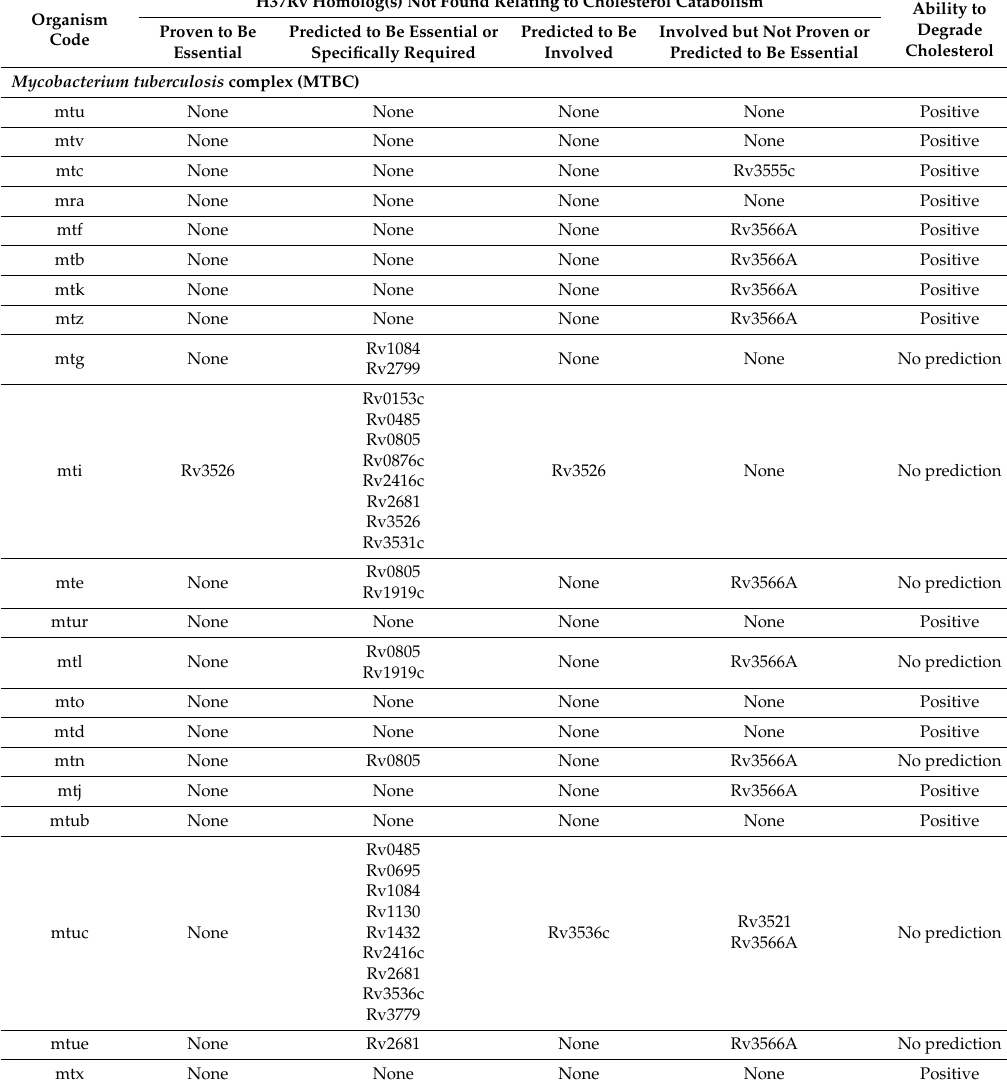
Table 2. Comparative analysis of cholesterol degrading genes/proteins in mycobacterial species. M. tuberculosis H37Rv homologs belonging to different categories not found in mycobacterial species were listed under different categories. The relevant data on BLAST analysis, homolog proteins and protein family analysis are presented in Supplementary Datasets 1–3, respectively. The cholesterol catabolic ability of mycobacterial species was predicted following the presence of genes/proteins that are proven to be essential, and predicted to be essential or specifically required for M. tuberculosis H37Rv growth on